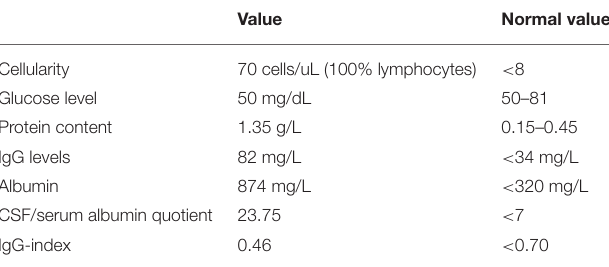
TABLE 2 | Cerebrospinal fluid (CSF)